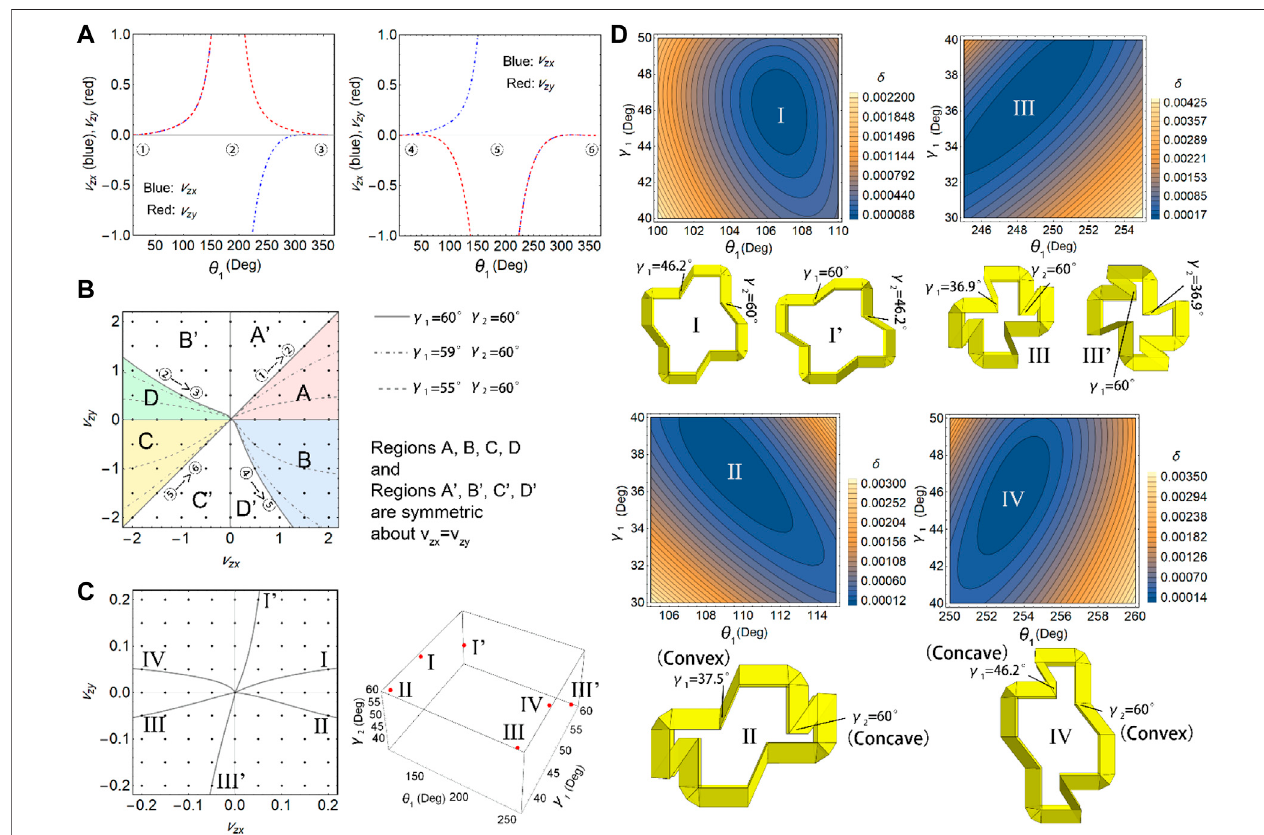
FIGURE4| OptimaldesignforthetargetedPoisson ’ sratiosinthex-andy-directions. (A) Poisson ’ sratiosalongdifferentdeformationpathswith γ 1 (cid:1) γ 2 (cid:1) 60 ° . (B) With γ 1 < γ 2 (cid:1) 60 ° , the region in the 2D Poisson ’ s ratio space where the curve ( ] zx , ] zy ) can reach are plotted. Pink region, deformation from ① → ② ; green region, ② → ③ ; blue region, ④ → ⑤ ; and yellow region, ⑤ → ⑥ . (C) Optimal design for selected Poisson ’ s ratios ( ] (− 0 . 2 , − 0 . 05 ) , (− 0 . 05 , − 0 . 2 ) , and (− 0 . 2 , 0 . 05 ) at points I, I ′ , II, III, III ′ , and IV in the Poisson ’ s ratio space, respectively, and the corresponding optimal parameters (red points) in the design space. (D) Searching for the optimal parameters in the design space with γ 2 (cid:1) 60 ° . Top: contour plots of δ ; bottom, con fi gurations. For I,